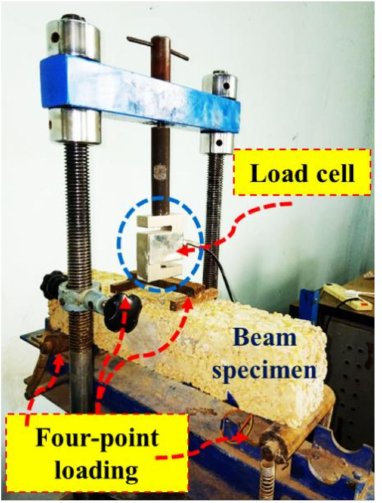
Figure 2. Four-point bending